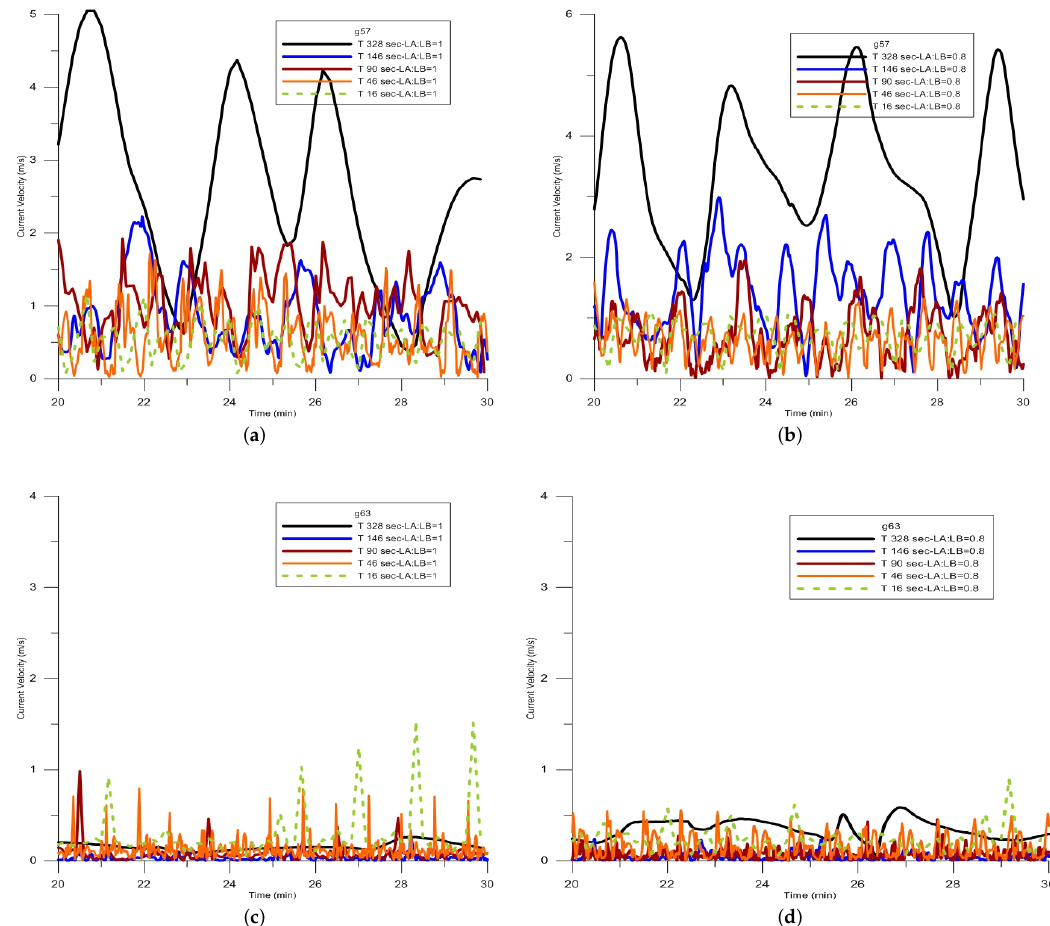
Figure 5. Time history of the current velocity computed by the simulation of the sinusoidal line crest long wave with a 1-m wave amplitude with T = 16 s, T = 46 s, T = 90 s, T = 146 s, T = 328 s for LA/LB = 1 (left column), for LA/LB = 0.8 (right column) in Gauge 57 ( a , b ) and Gauge 63 ( c , d